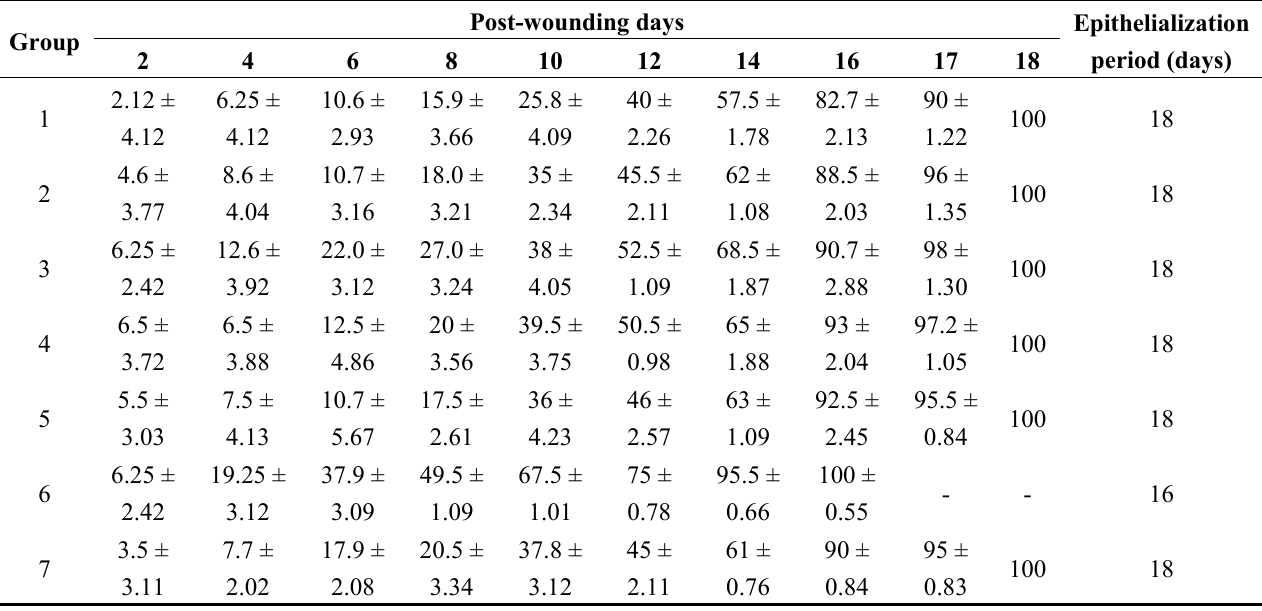
Table 2. Effect of carbazole alkaloids [mahanine (G2), mahanimbicine (G3), mahanimbine (G4)], essential oil (G5) and extract (G6) of Murraya koenigii , normal healing (G1) and standard ointment (G7) on percentage of wound healing and epithelialization period of excision wound model in